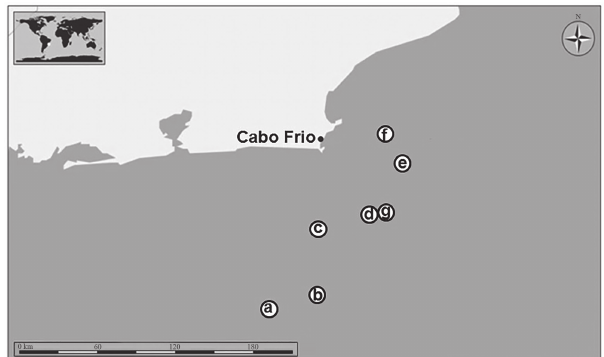
Fig. 1. Map of Cabo Frio/RJ region, with the fishing locations of the samples. a. 24° 04’ 33.55’’ S and 42° 25’